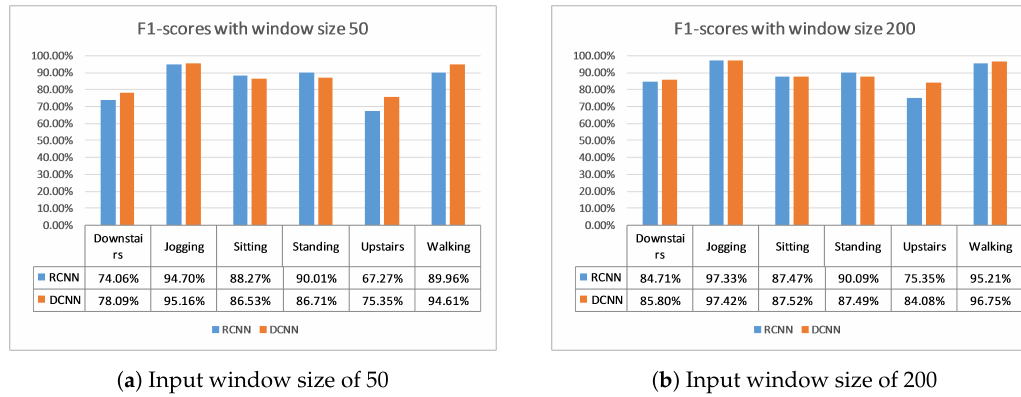
Figure 4. F1-scores on the original train/test split of the WISDM